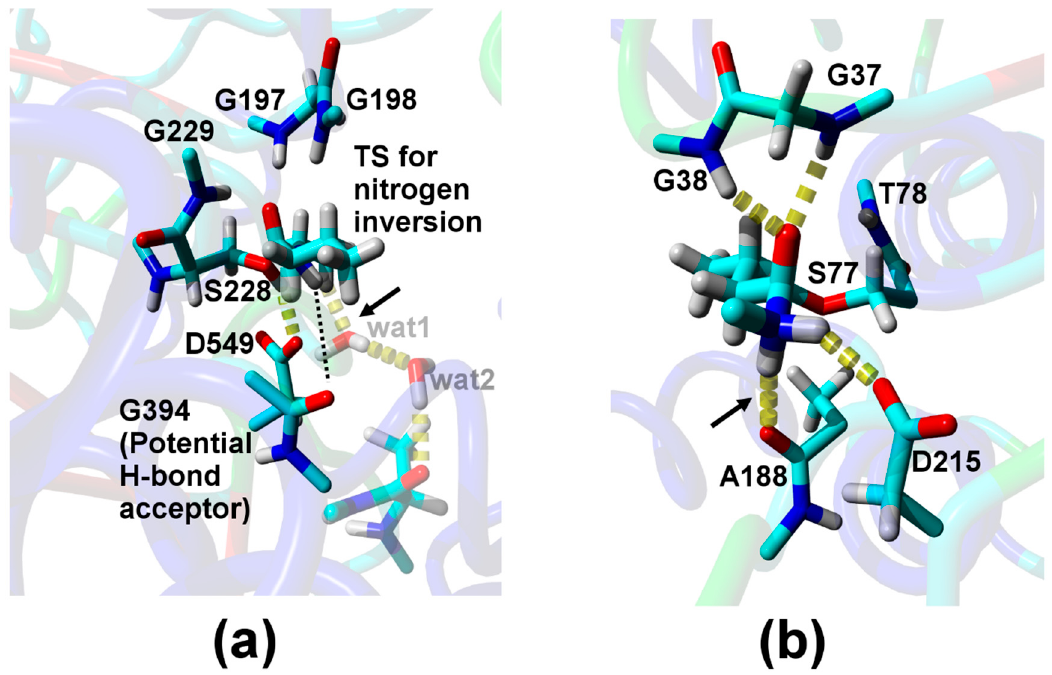
Figure 2. Mechanism-guided discovery of promiscuous enzyme scaffolds. ( a ) The transition state for nitrogen inversion (bold sticks) calculated using density functional theory (DFT) in the C. antarctica lipase B I189A variant [29] was docked into the crystal structure of human phospholipase A 2 (PDB 1CJY [38]). The discovered backbone carbonyl of G394 in human phospholipase A 2 that could act as a potential hydrogen bond acceptor to the transition state is highlighted by the dotted line (corresponding to a distance of 4.1 Å). For reference, parts of the C. antarctica lipase B engineered variant is shown in faded sticks highlighting the mechanistically important hydrogen bond for inversion (arrow) mediated through two water molecules [29] and accepted by the more distal and exposed backbone (shaded). The catalytic serine, acid and residues of the oxyanion hole in human phospholipase A 2 are labeled. ( b ) Snapshot from a molecular dynamics (MD) simulation of the second tetrahedral intermediate during acylation of S. cardiophyllum patatin. The key hydrogen bond accepted by the discovered backbone carbonyl of A188 (corresponding to G394 in human phospholipase A 2 ) facilitating inversion is shown by the arrow. The catalytic serine (S77), aspartic acid (D215), and residues of the oxyanion hole in patatin are labeled.